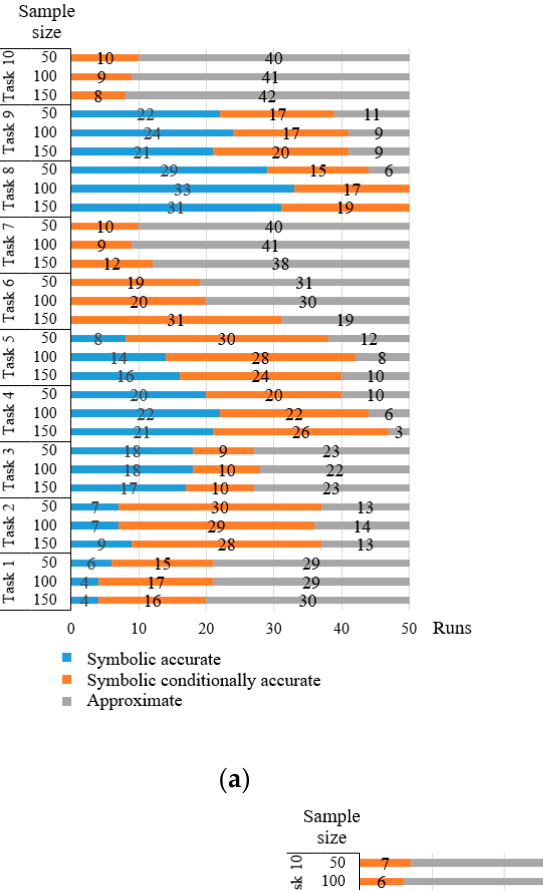
Figure 7. Symbolic accuracy of the resulting ODEs: ( a ) Data without noise; ( b ) Data with 5% of noise; ( c ) Data with 10% of noise.